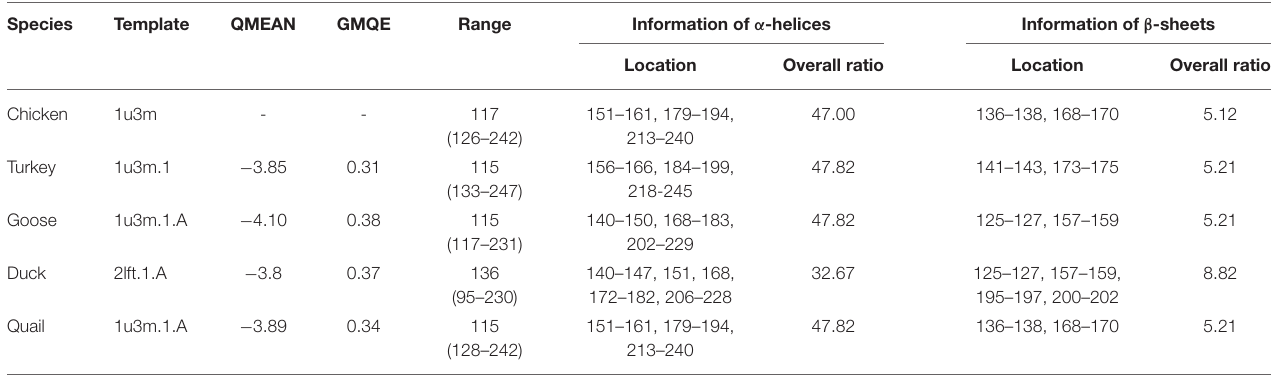
TABLE 6 | Detailed information on the secondary and tertiary structures of avian prion proteins (PrPs). Species